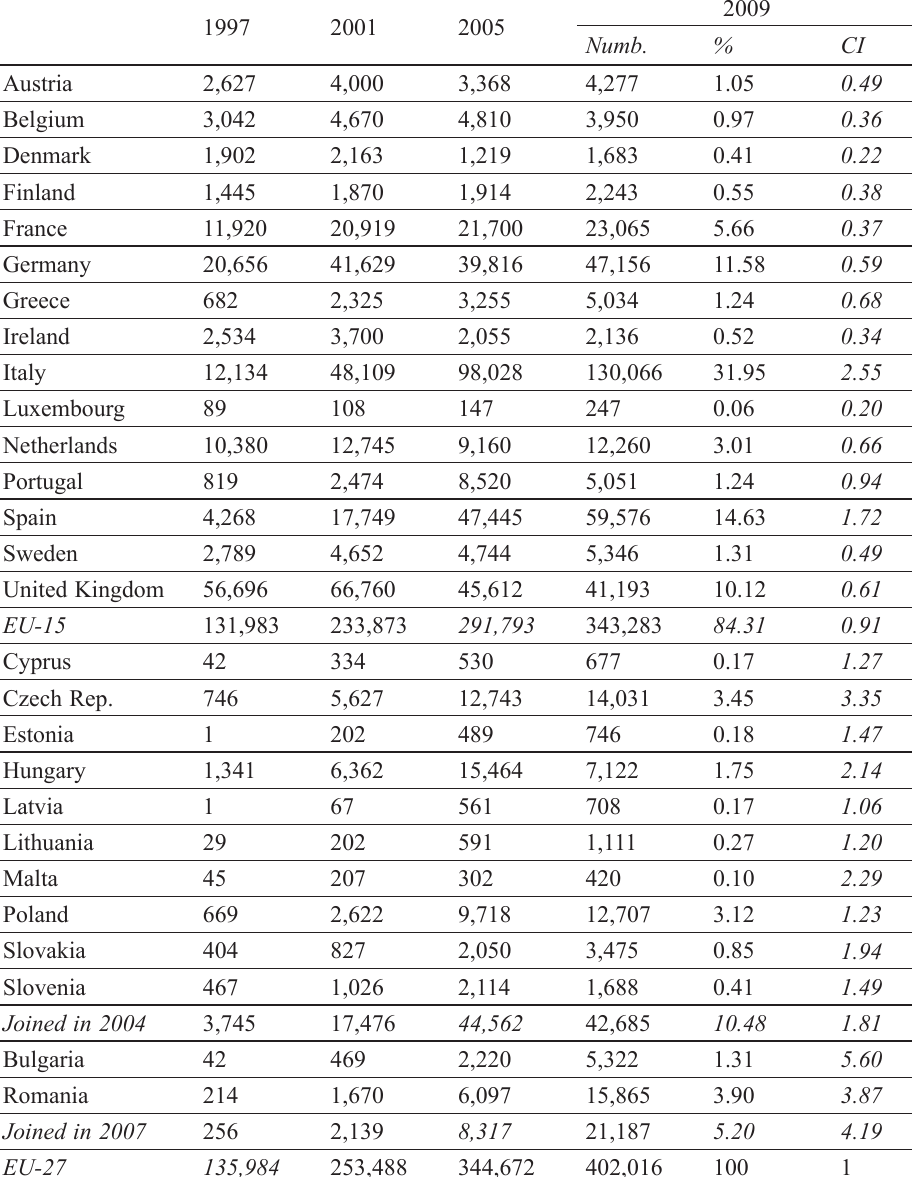
Table 3. Evolution of ISO 9000 certification within the